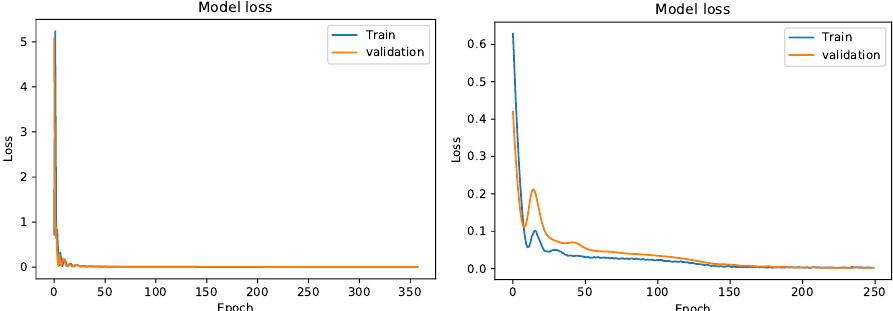
Figure 9. Model loss during training. The left side shows the loss of tomato yield prediction model and the right side shows potato yield prediction model.